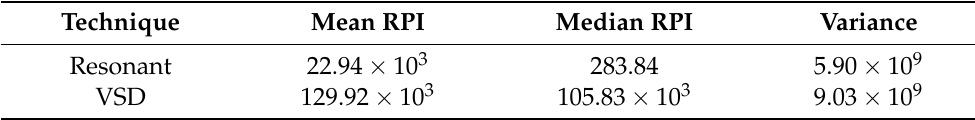
Figure 8. Statistical comparison in RPI distribution between the two strategies. Table 3. RPI analysis